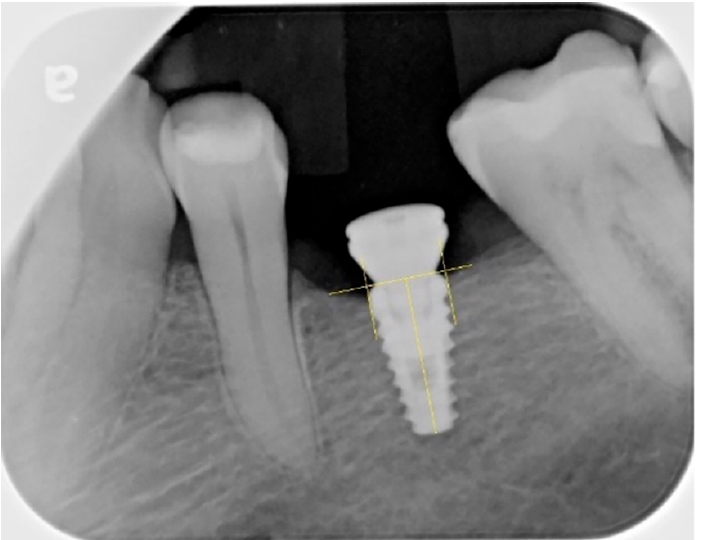
Figure 1. Radiographic image showing the procedure for marginal bone level (MBL) measure- ment.